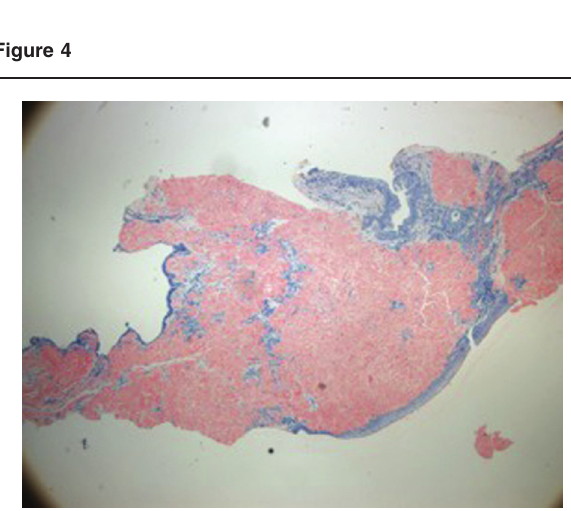
Laryngeal amyloidosis postablation using CO 2 laser.